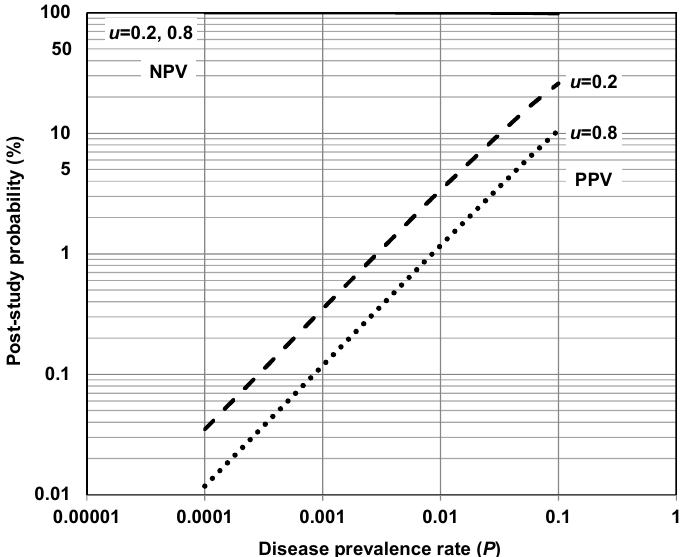
Figure 1. Theoretical probability of a research finding in a study being true as a function of disease prevalence rate for various levels of bias (u) (Note: For α = 0.05 and power = 80%; NPV = negative predictive value—probability that a negative (null) relationship (i.e., risk factor does not cause disease) is true; PPV = positive predictive value—probability that a positive relationship (i.e., risk factor causes disease) is true. Relationships for this figure are developed in SI 1).